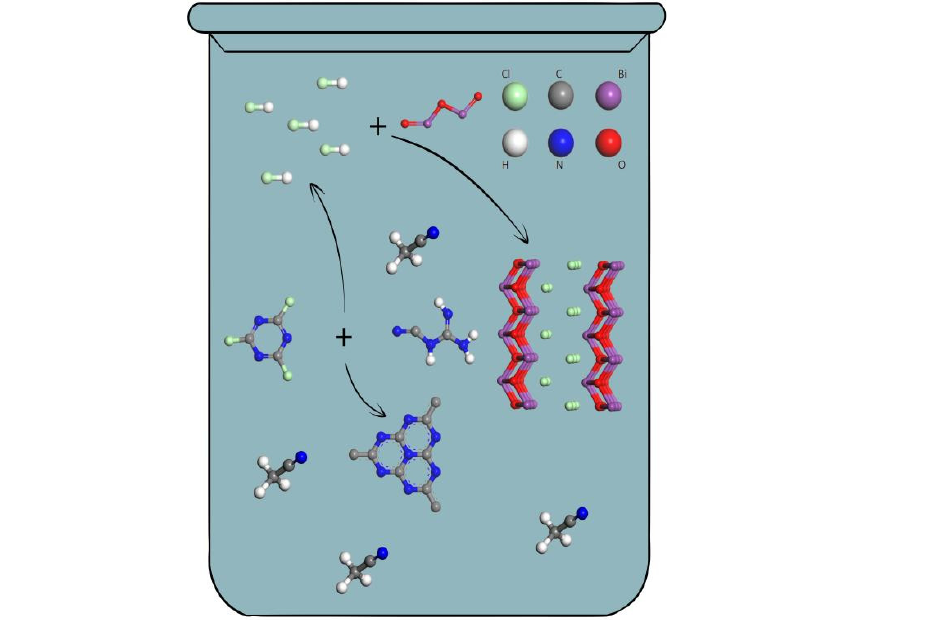
Figure 1. Reaction process of one-pot method.